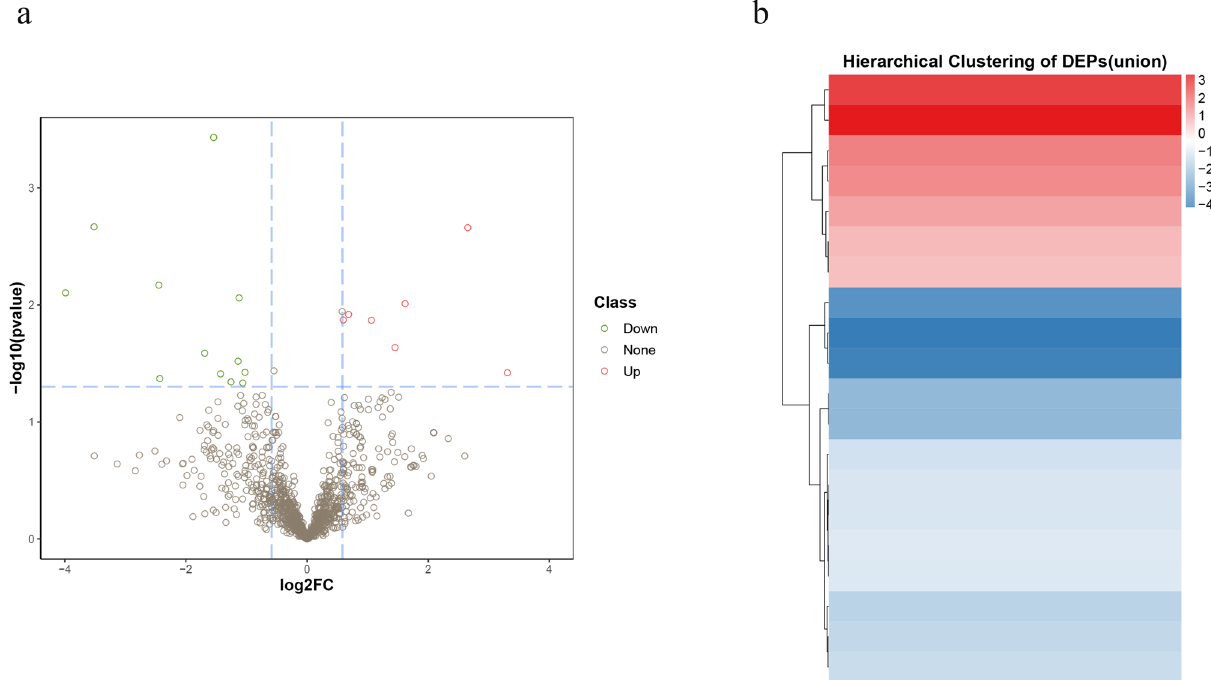
Figure 2. Differentially expressed proteins (DEPs) were identified and clustered in Covid-19 patients with pulmonary fibrosis. ( a ) Volcano plots of total protein levels. Red dots, significantly upregulated proteins; green dots, significantly downregulated proteins. ( b ) Cluster chart of DEPs. Red rows, significantly upregulated proteins; blue rows present significantly downregulated